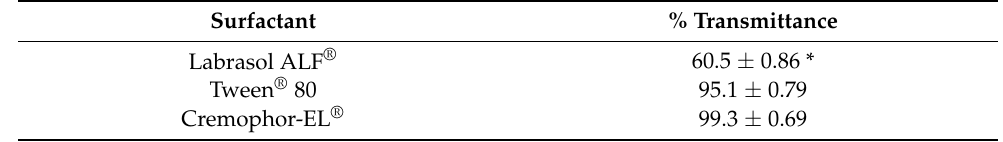
Table 1. Ability of the selected surfactants to emulsify the oil Capryol PGMC ® .